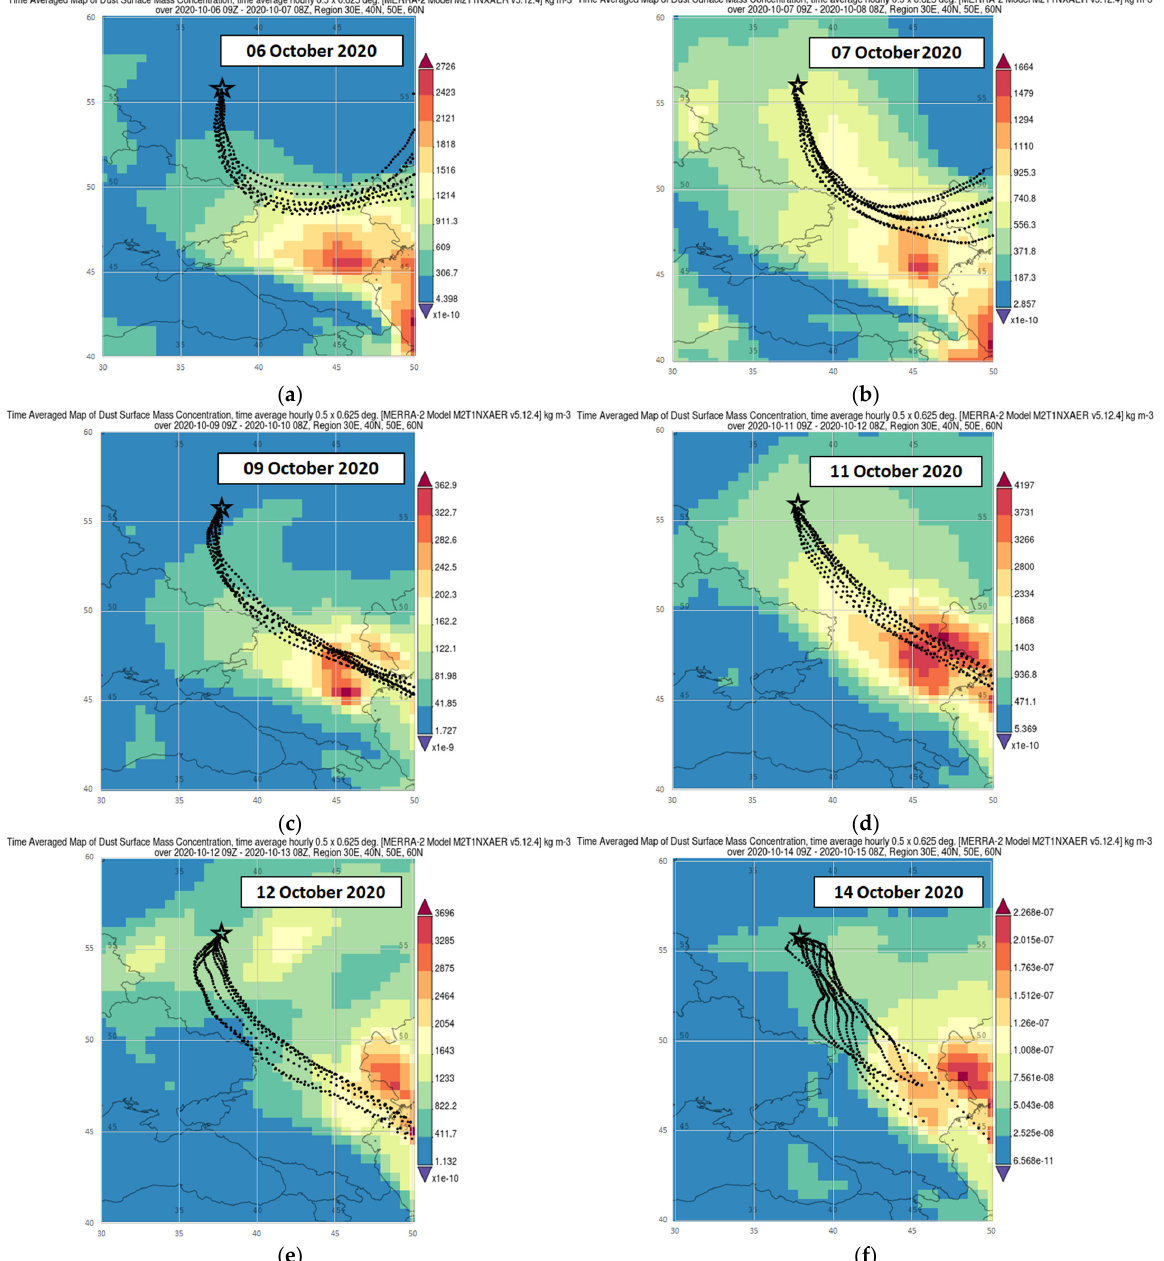
Figure 8. The development of the episode No. 2 (5–15 October 2020): examples of dust propagation (as an indicator of dust storm emissions) over the territory of the southern half of ETR (according to MERRA-2 reanalysis [81]) and air mass transport trajectories (black dots) to Moscow (asterisk) for individual daysfrom 6 to 14 October 2020 (the dates are shown in the pictures). The color scales of dust concentration on the maps are different, kg/m 3 .